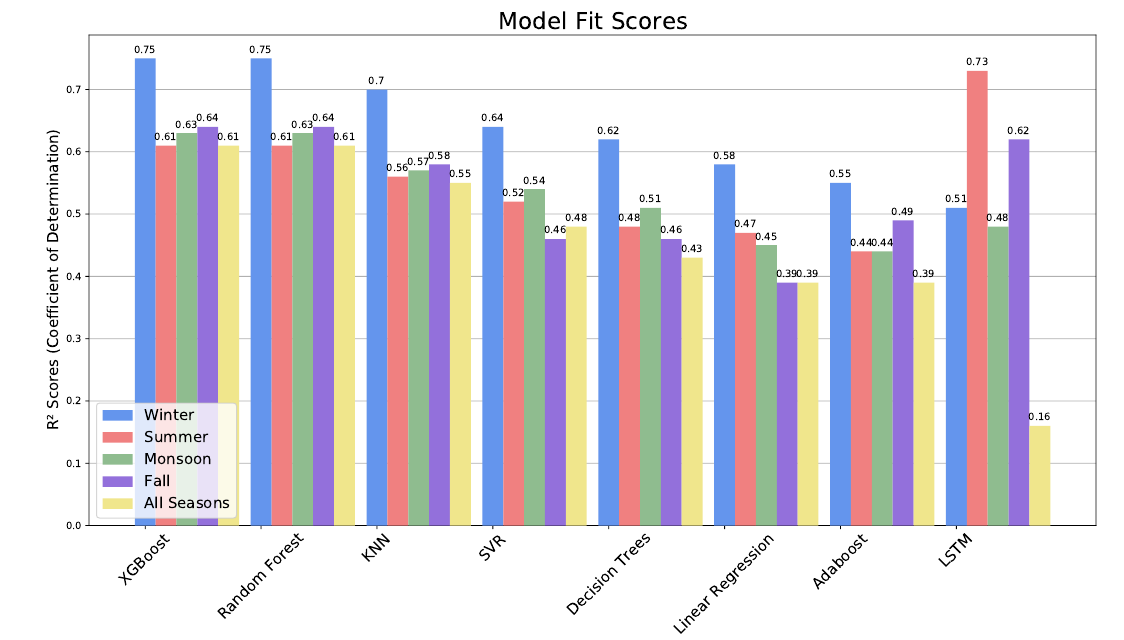
Figure 15. Actual versus predicted results of XGBoost for each season.